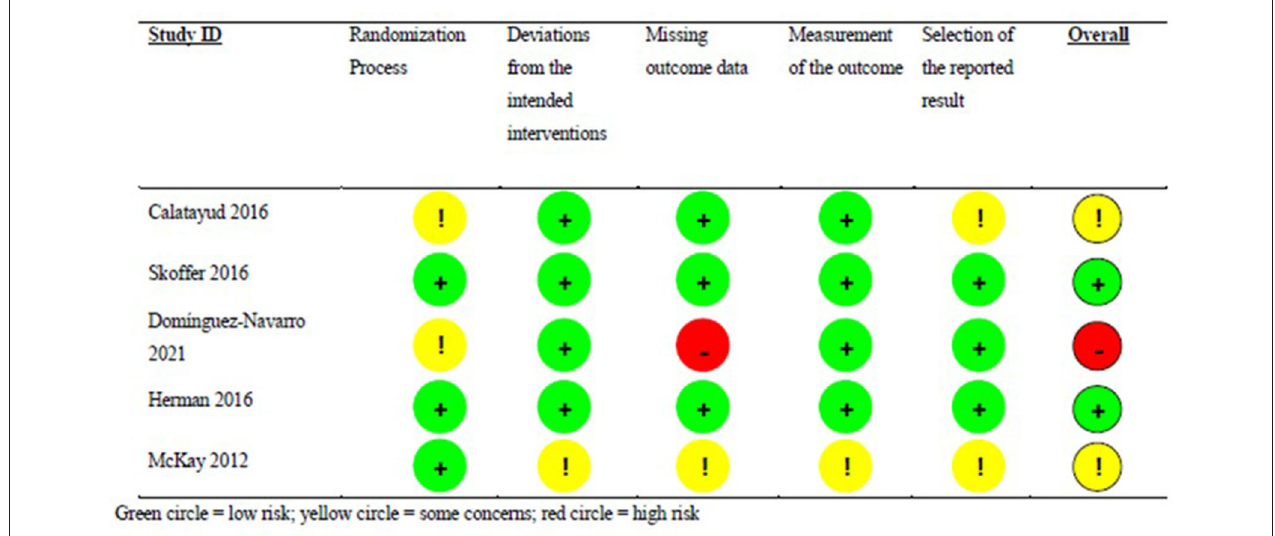
FIGURE 1 | Risk of Bias Assessment for each individual study. Green circle, low risk; yellow circle, some concerns; red circle, high risk.